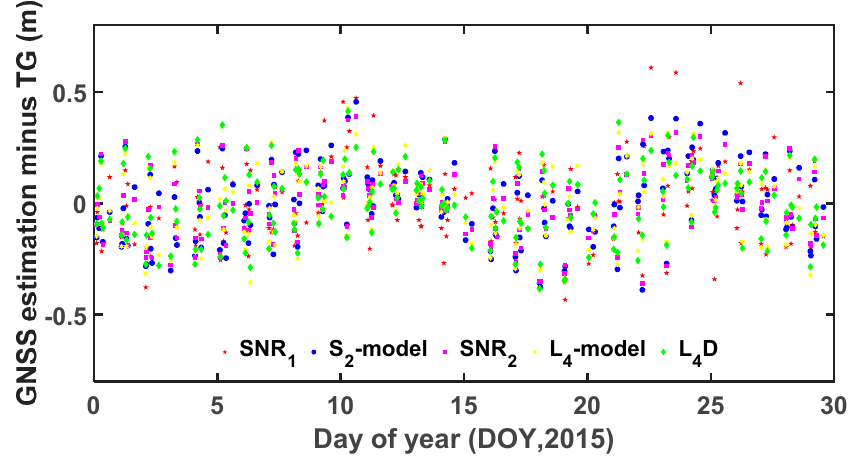
Figure 9. Residuals of sea surface height differences compared between SNR and geometry-free phase estimations for the elevation range 5–15° and tide gauge (TG) observations.